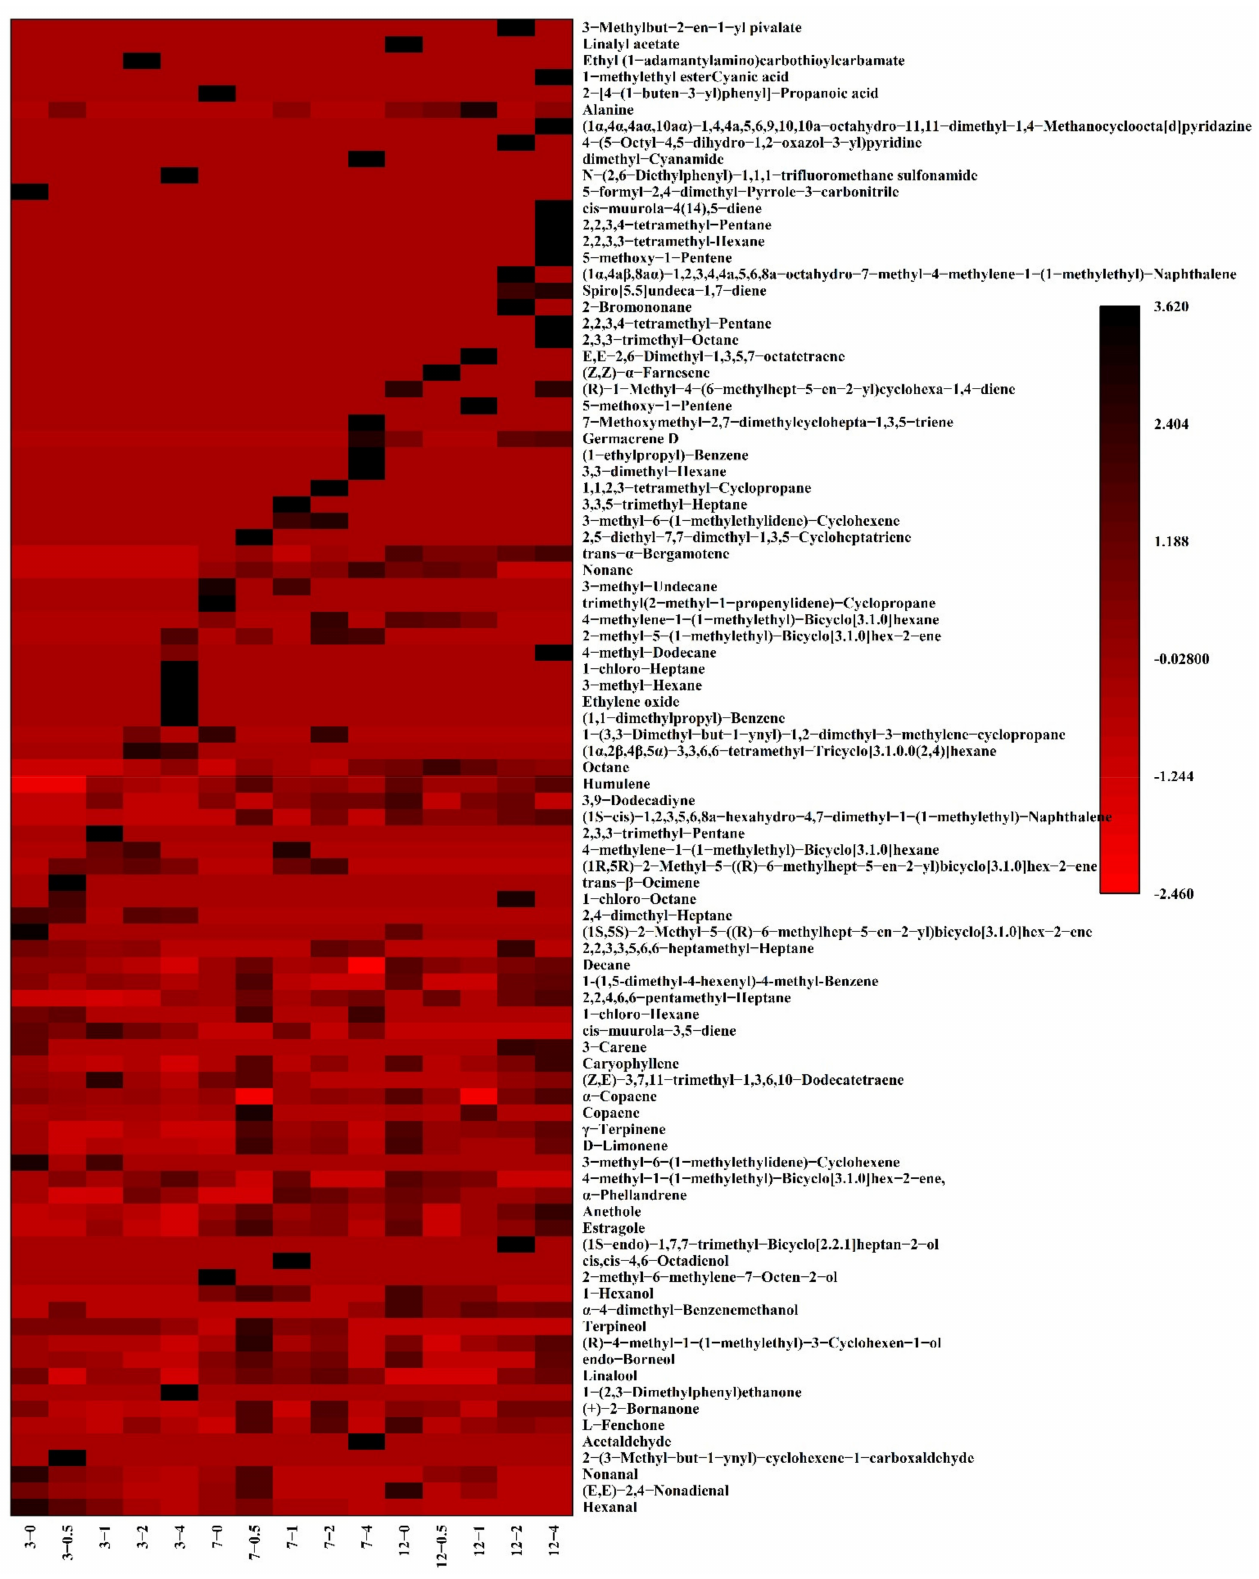
Figure 5. Heatmap display of goose meatballs measured by